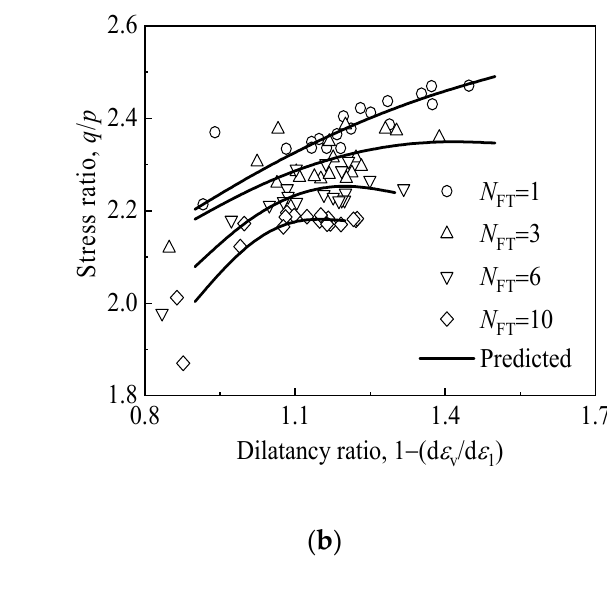
Table 1. Empirical Constants, a , b , and c .